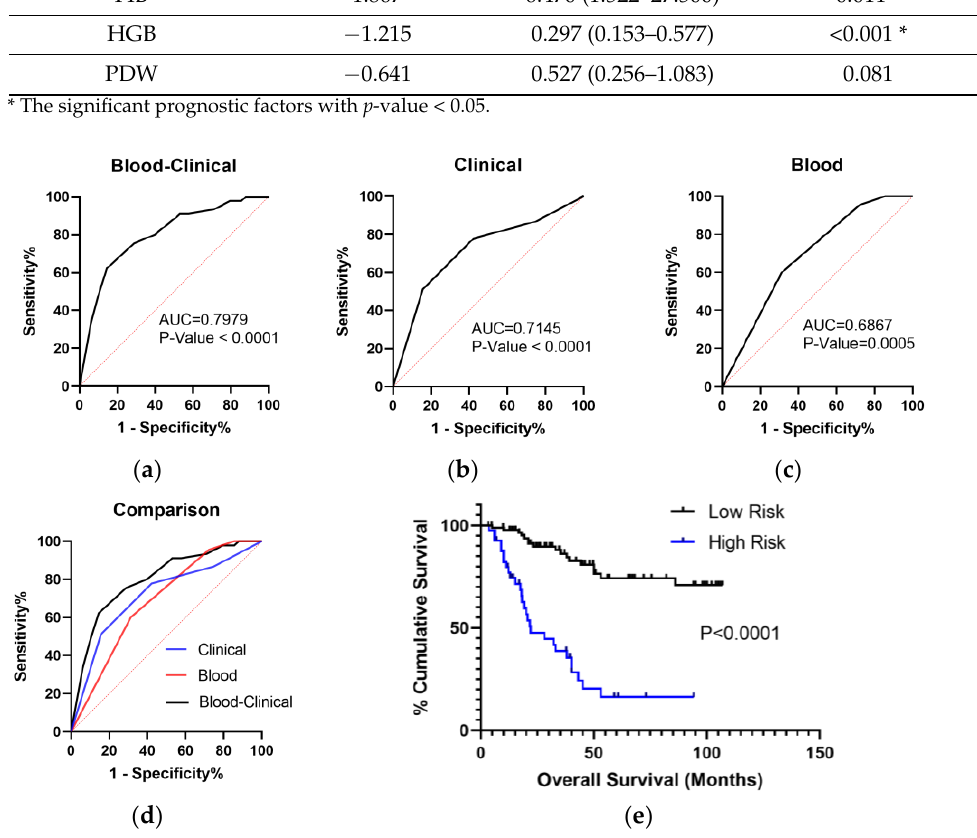
Figure 6. ROC analysis of the blood–clinical model to predict OS in LSCC. ( a ) ROC curve of the blood–clinical model involving fibrinogen (FIB), hemoglobin (HGB), age, and clinical stage. ( b ) ROC curve of the clinical model involving age and clinical stage. ( c ) ROC curve of the blood model involving FIB and HGB. ( d ) The comparison of AUC among the blood–clinical model, clinical model, and blood model. ( e ) According to the blood–clinical model, K-M analysis with a log-rank test of OS in patients with high or low